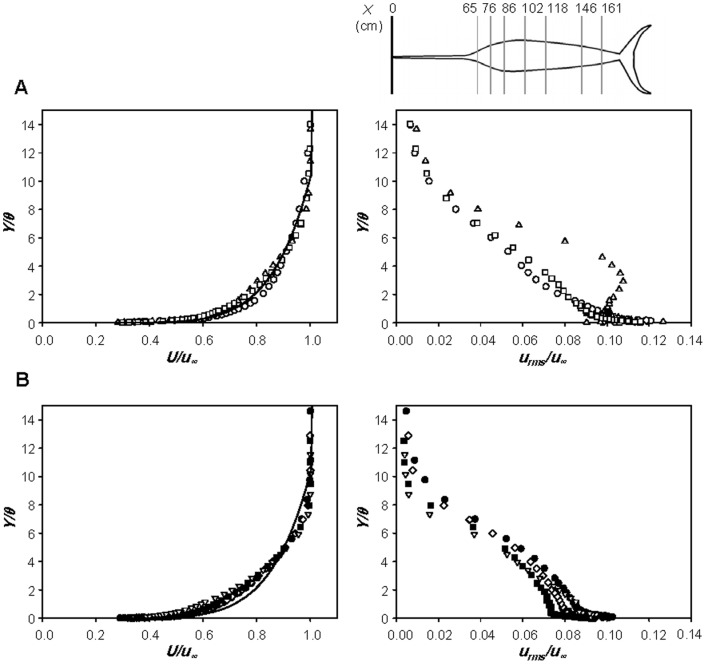
Velocity profiles over the body surface of the swordfish.Profiles of the mean streamwise velocity (left) and rms streamwise velocity fluctuations (right) at the anterior A, middle and posterior B parts of the swordfish: ○, X/TL  = 0.325 (65 cm; ReX  = 8.67×105); △, 0.380 (76 cm; ReX  = 1.01×106); □, 0.430 (86 cm; ReX  = 1.15×106); •, 0.510 (102 cm; ReX  = 1.36×106); ⋄, 0.590 (118 cm; ReX  = 1.57×106); ▪, 0.730 (146 cm; ReX  = 1.95×106); ▽, 0.805 (161 cm; ReX  = 2.15×106). –, turbulent boundary layer profile (1/7th power law) [45]. Here, X is the streamwise distance from the tip of bill, Y is the wall-normal distance from the body surface and θ is the momentum thickness (Table 2). The velocities are measured along the centerline of side surface of the swordfish at ReTL  = 2.67×106. Shown at the top are the measurement locations in the streamwise direction.